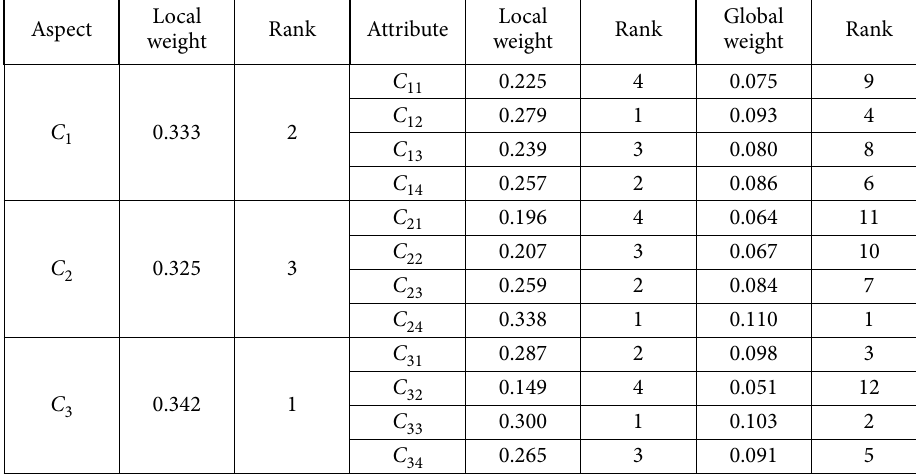
Table 8. Influential significance weight on aspects and